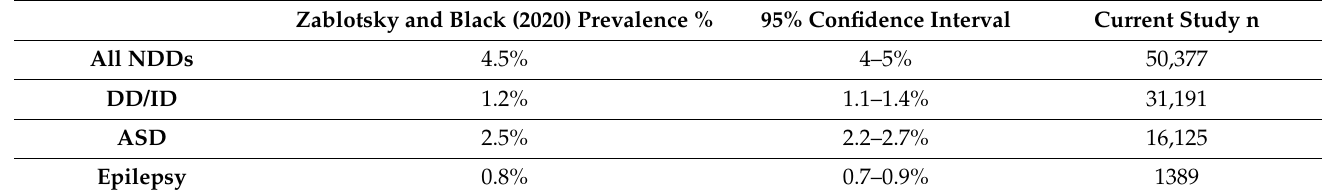
Table 1. Prevalence estimates from Zablotsky and Black, 2020 of each disorder among 3- to 17-year old children in the